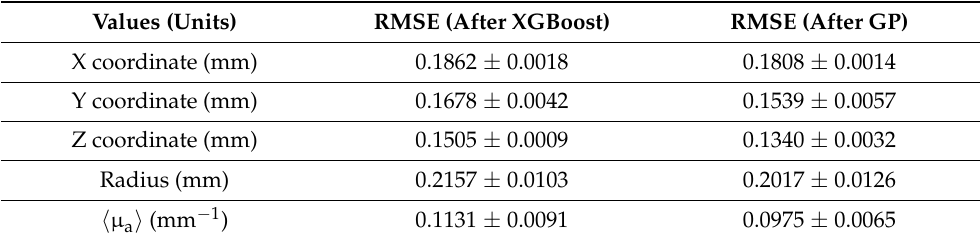
Table 2. Performance of the proposed model in terms of